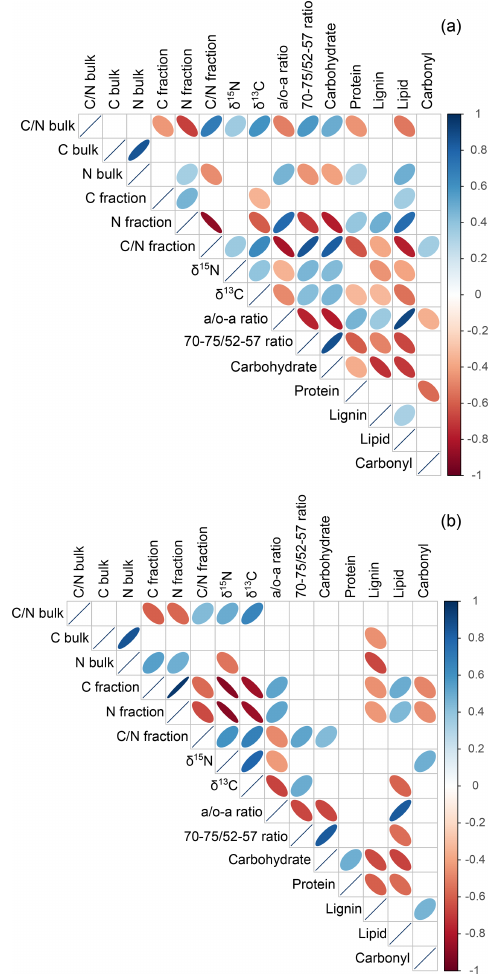
Figure 8. Correlation matrices of POM fractions: the large POM (occluded particulate OM and free particulate OM) frac- tions (a) show different correlations compared to small occluded particulate OM fractions (b) . The more intense the color and the smaller the ellipses are, the stronger the correlation is: blue indi- cates a positive correlation, and red indicates a negative correlation; the direction of ellipses is